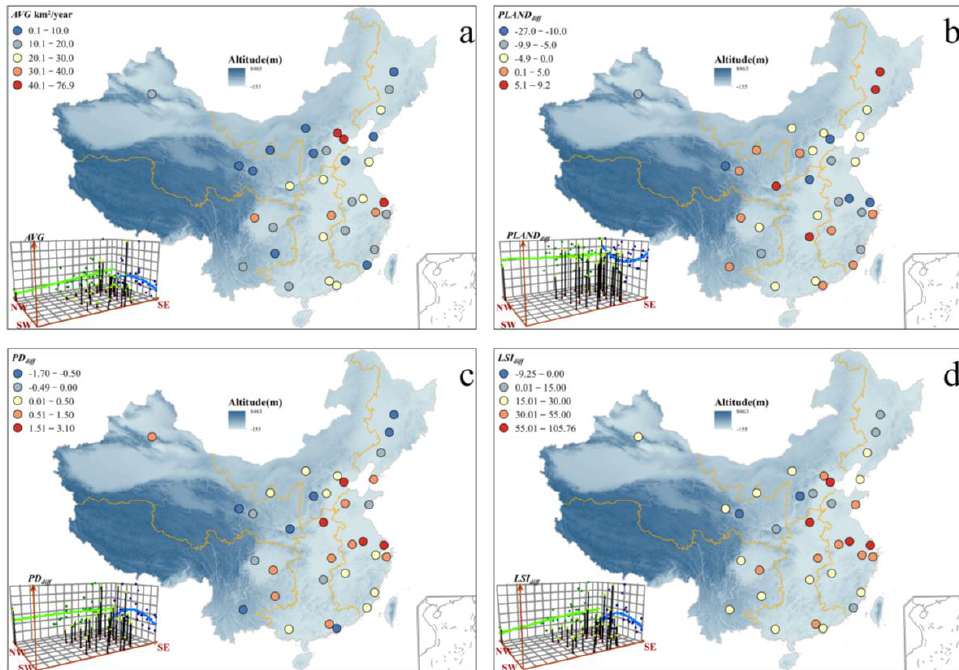
Figure 3. Spatial distributions of ( a ) the annual average expansion speed of built-up areas ( AVG ), ( b ) the difference in the proportion of built-up areas ( PLAND dif f ), ( c ) the difference in the built-up patch density ( PD dif f ), and ( d ) the difference in the shape index of built-up areas ( LSI dif f ) in 34 cities between 2020 and 2000. Inset plots show results from the global spatial trend analysis, where the green and blue lines are fitting trend lines along the east-west and north-south directions, respectively. The 34 cities were divided into three types according to the topography of each city.